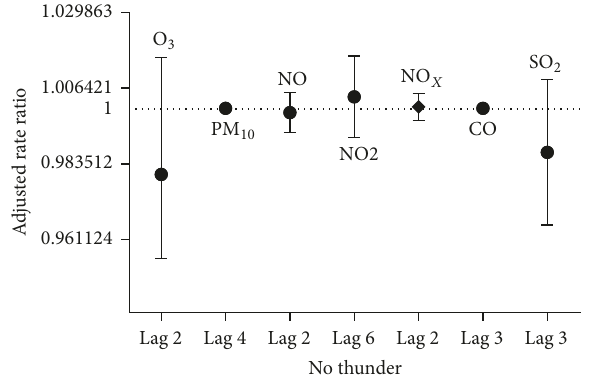
Figure 6: Strongest correlations between air pollutants and hospital admissions for asthma and bronchospasm happening up to 7 days later in nonepidemic